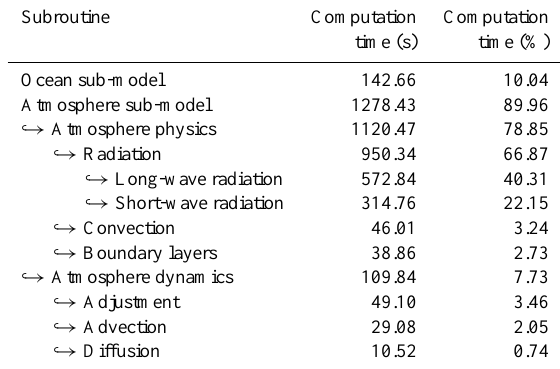
Table 1. The CPU time used by the main sub-components of FA- MOUS. The first column shows the absolute time measured on the CELL’s PPE for a one month simulation (720 atmosphere time- steps, 60 ocean time-steps). We used both the gettimeofday function and the PowerPC’s hardware instruction counter to mea- sure the intervals. The second column shows the relative CPU